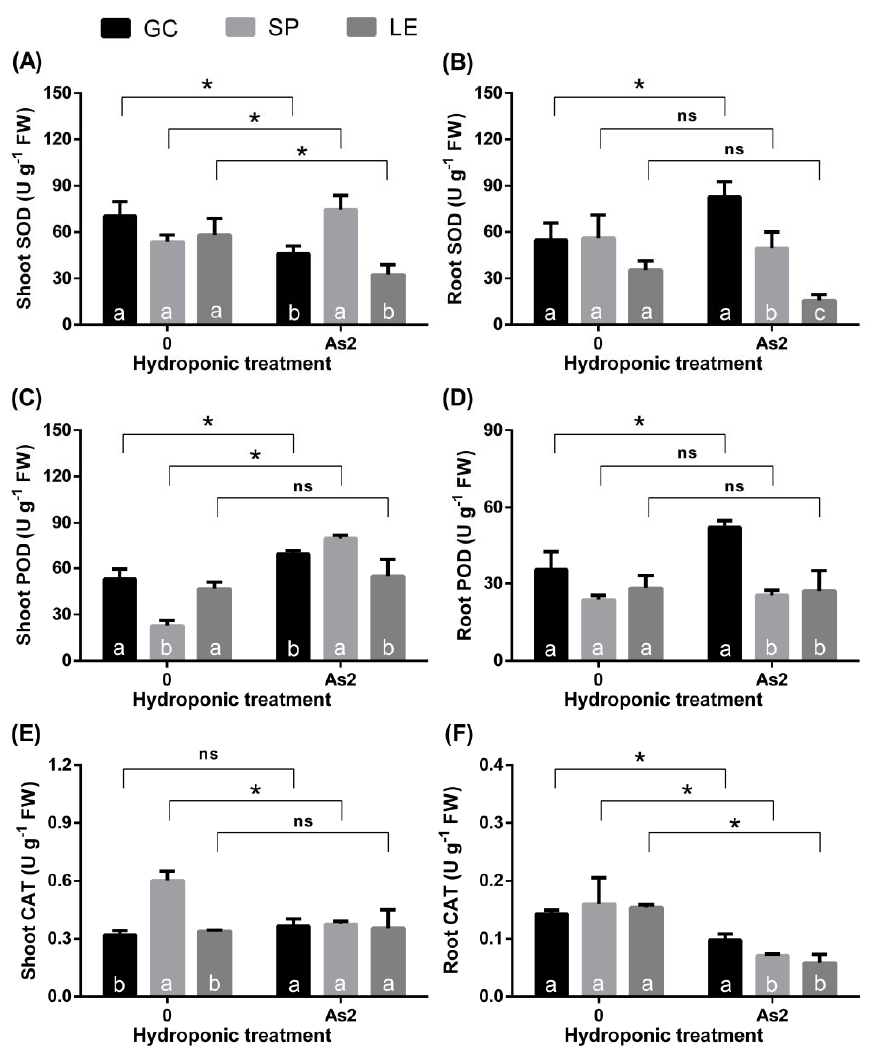
Figure 5. SOD ( A , B ), POD ( C , D ), and CAT ( E , F ) activities in the shoots and roots of GC, SP, and LE in the hydroponic As treatment. Note: Different lowercase letters in the figure indicate comparisons between different vegetables under the same treatment (5% levels). The symbol * indicates that the difference between values is significant at the respective 5% levels. The error bars in the graph indicate the SEM (standard error of the mean).